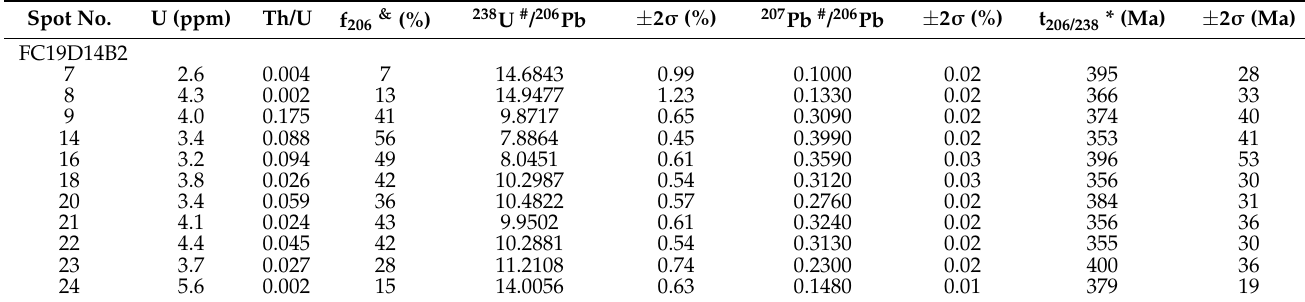
The rutile from the gneiss has a relatively uniform U content of 1–7 ppm, but a variable value of f 206 between 7 and 65% (Table 3). Regression of the data points on the Tera–Wasserburg plot gives a lower intercept age of 386 ± 16 Ma with a MSWD value of 1.1, and the upper intercept with a 207 Pb/ 206 Pb ratio of 0.72 ± 0.52 for the common Pb composition (Figure 6A). Applying the 207 Pb-based common Pb correction method of [24], a weighted mean 206 Pb/ 238 U age of 374 ± 9 Ma (MSWD = 0.9) is obtained, which is consistent with the lower intercept age within error. Table 3. LA-ICP-MS rutile U–Pb analyses. Spot No.